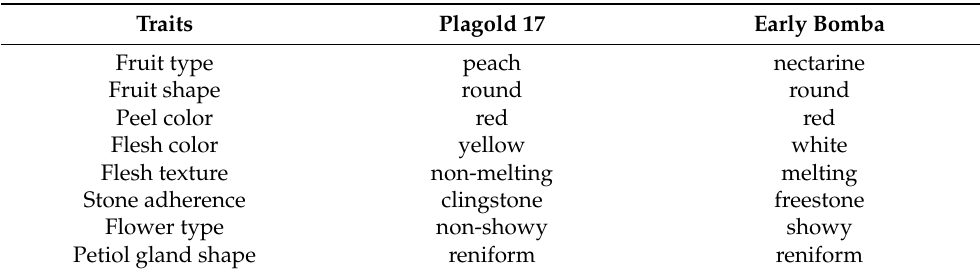
Table 1. Peach cultivars, fruit type, skin color, flesh color, flesh texture, stone adhesion, flower type and gland type for the studied peach and nectarine